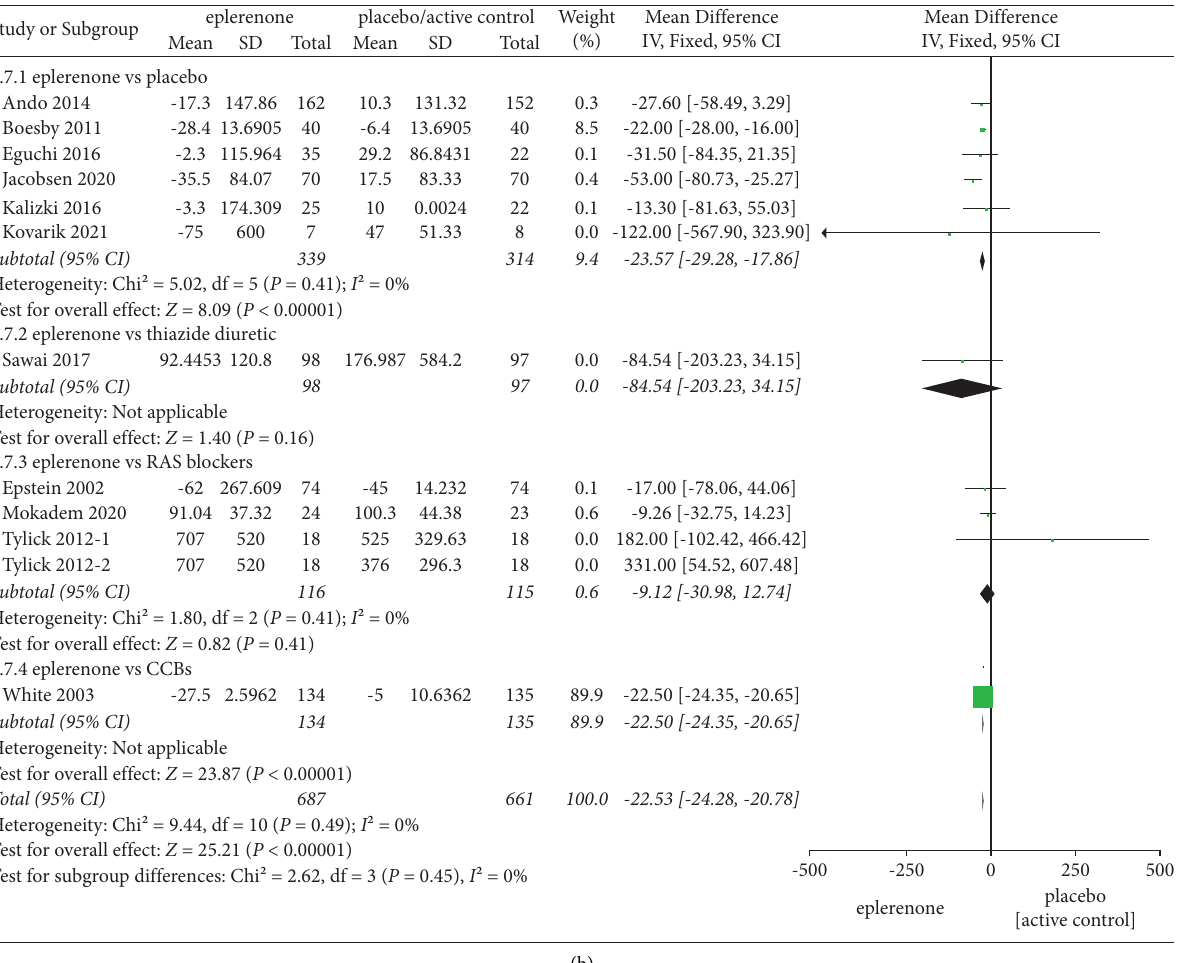
Figure 3: (a) Efect on 24-h proteinuria in articles comparing eplerenone to placebo/active control. (b) Efect on UACR for the eplerenone versus placebo/active control. Te black diamond indicates summary information with the center of the estimate pooled with the median diference, and the width covers the relevant 95%